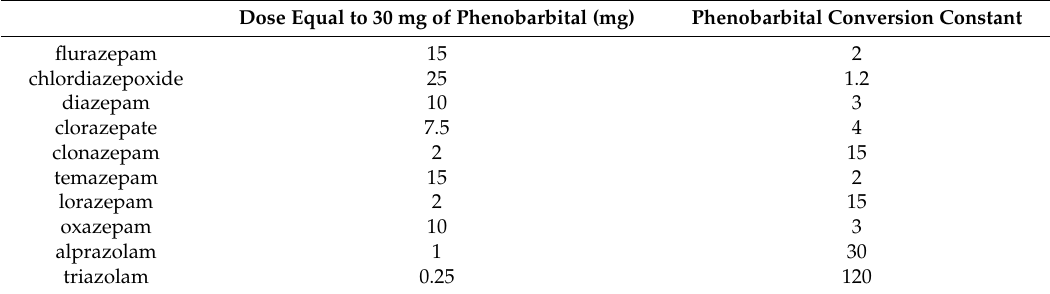
Table 3. Phenobarbital withdrawal equivalents of benzodiazepines (withdrawal equivalent doses are not the same as therapeutic equivalent